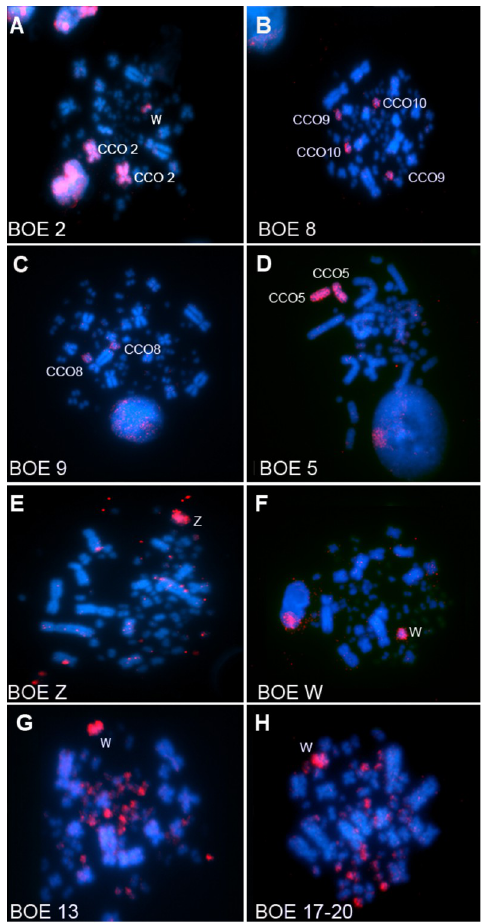
Fig 3. Chromosomal painting of whole chromosome probes of Burhinus oedicnemus on Charadrius collaris . The probes are visualized with avidin-Cy3 (red); chromosomes counterstained with DAPI (blue).